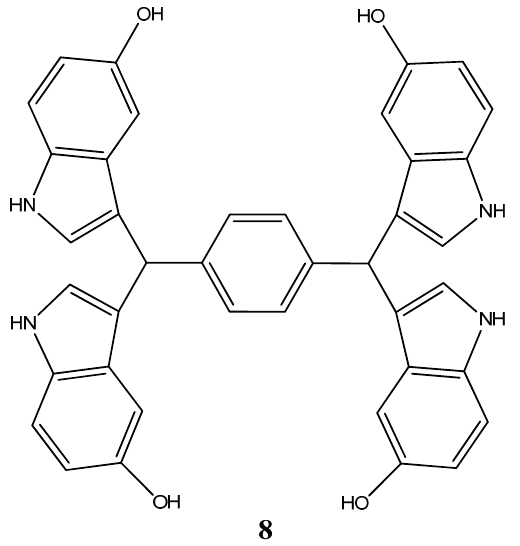
Figure 4. Chemical structure representation of a novel indole compound SK228 with reported antiproliferative activities through the induction of reactive oxygen species, activation of programed cell death processes and the disruption FAK/Paxillin pathway [30].